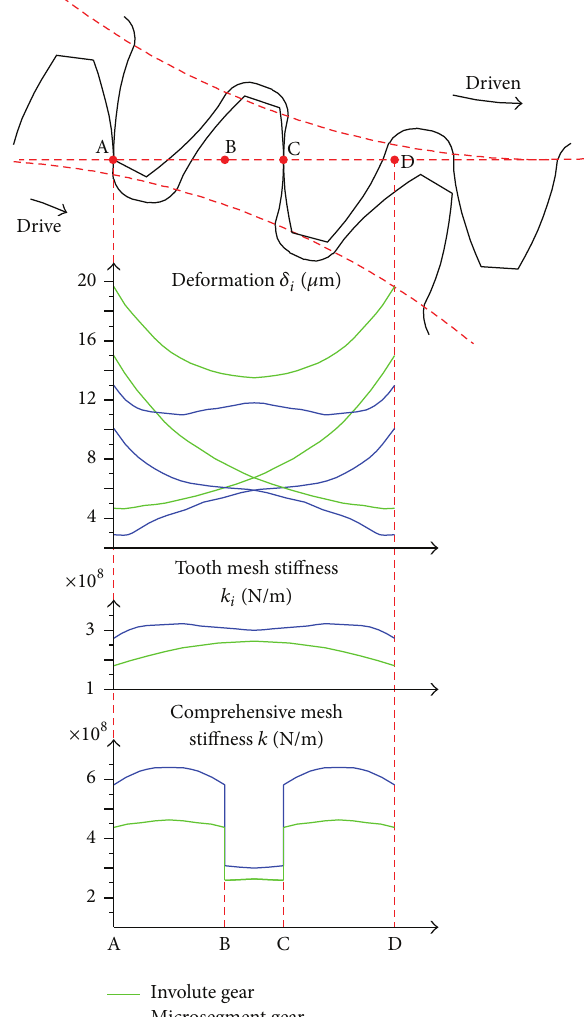
Figure 4: The deformation and stiffness of microsegment gear and involute